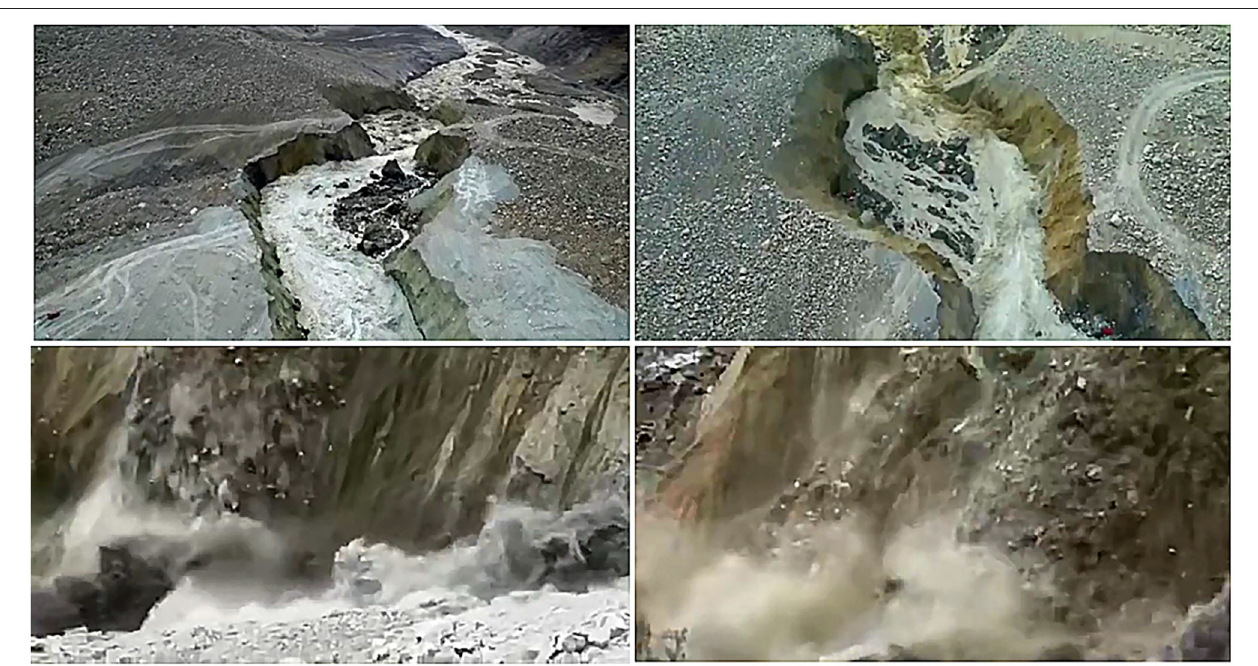
FIGURE 10 | Images of the breach process of the “November 3” Baige landslide dam (taken by the Ministry of Emergency Management of China and the Fire Brigade of Sichuan Province).